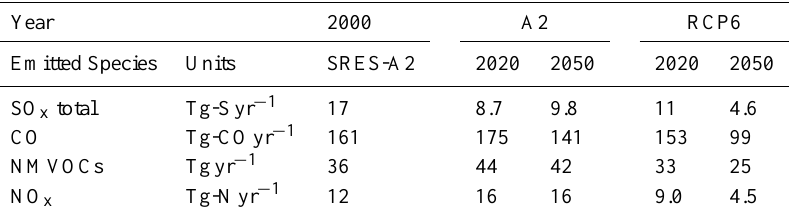
Table 2. Projected O 3 and Aerosol precursor emissions for 2020 and 2050 for the OECD group of countries from IPCC emission scenarios. SRES data is taken from IPCC (2000) and RCP data is taken from RCP Database